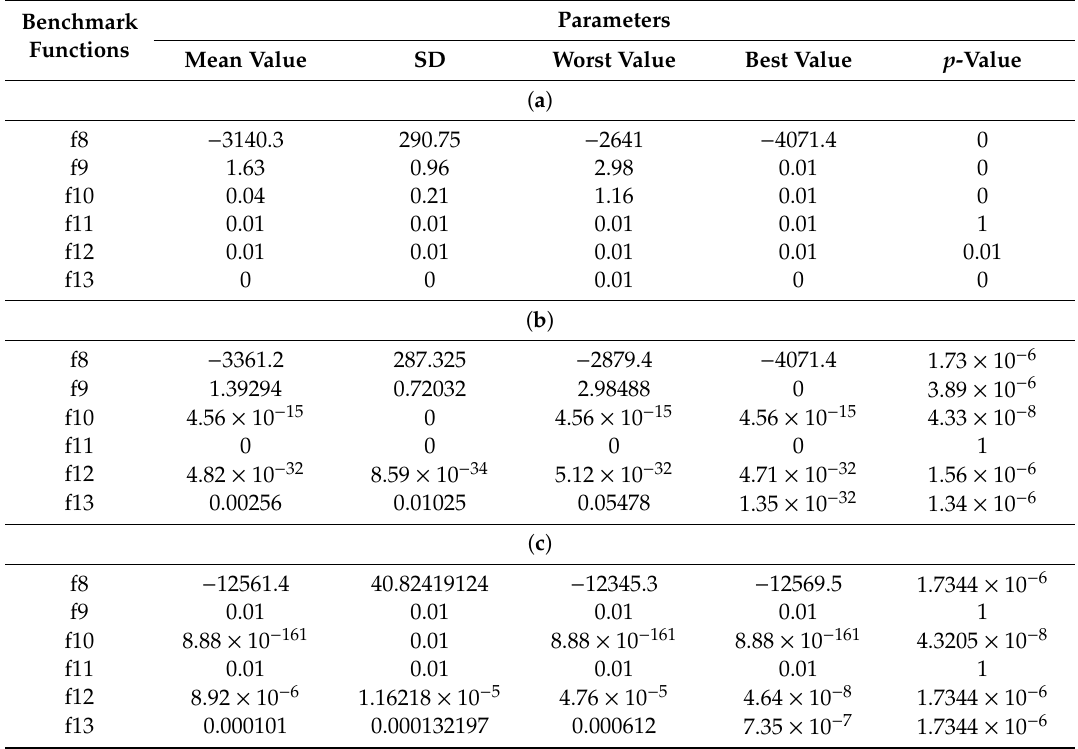
Table 6. ( a ) Outcomes of the BMFO1 algorithm. ( b ) Outcomes of the BMFO2 algorithm. ( c ) Results of the HHO